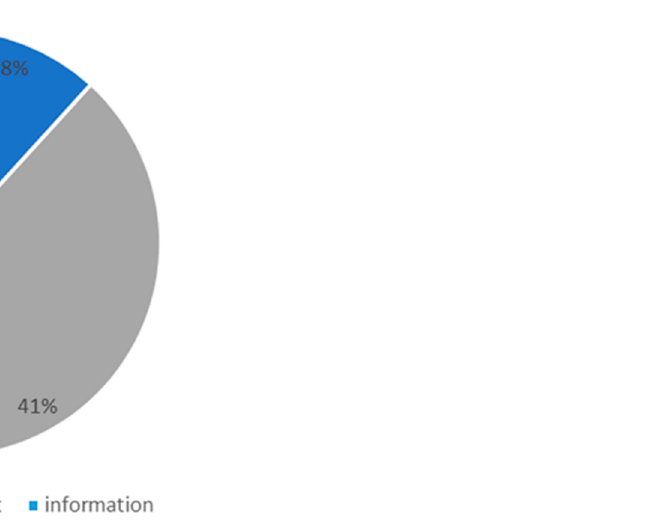
Figure 1. Pet foods and treats notifications of bacterial contamination in the Rapid Alert System for Food and Feed (RASFF) database (2017–2020).